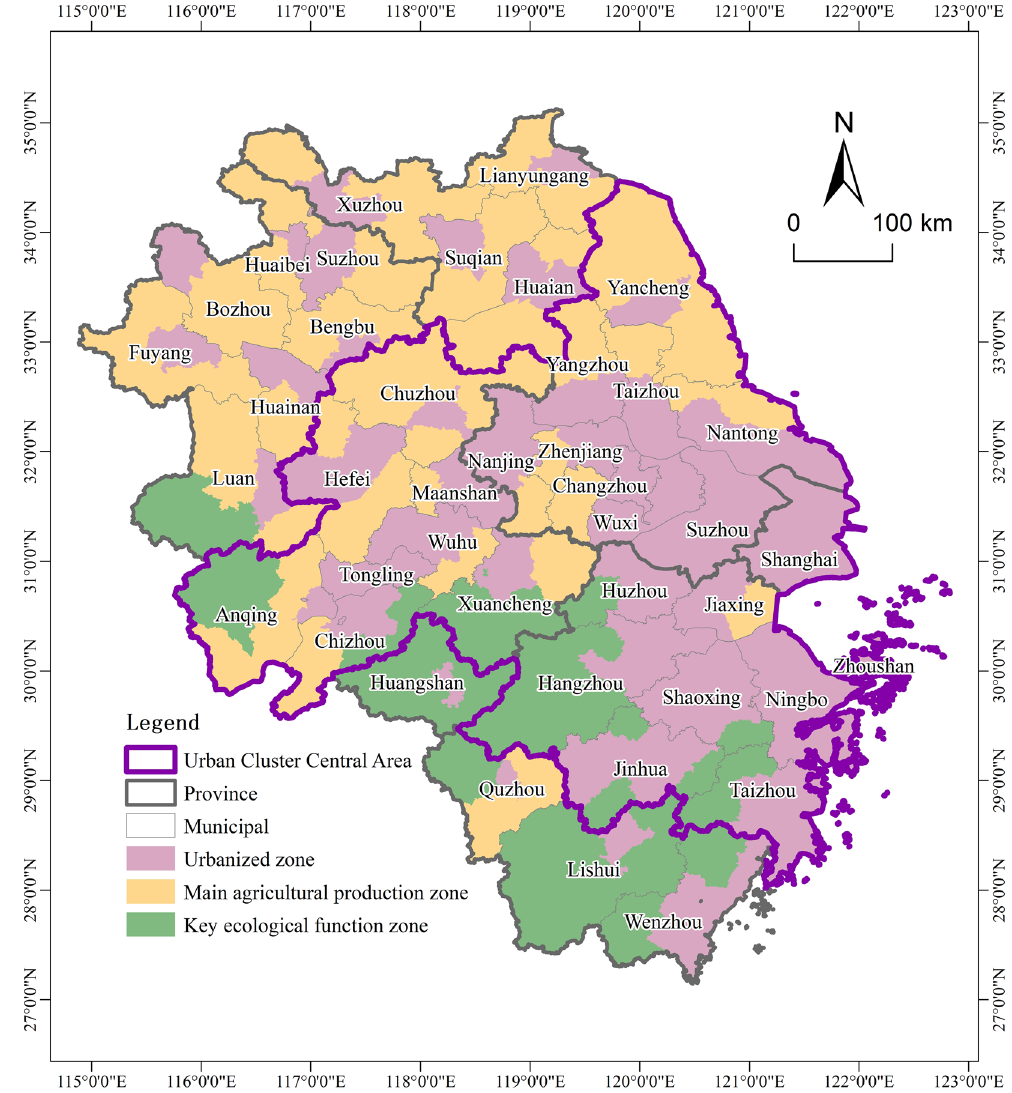
Figure 1. Scope of case area. Software: Arcgis 10.7. URL: https:// www. esri. com/ zh- cn/